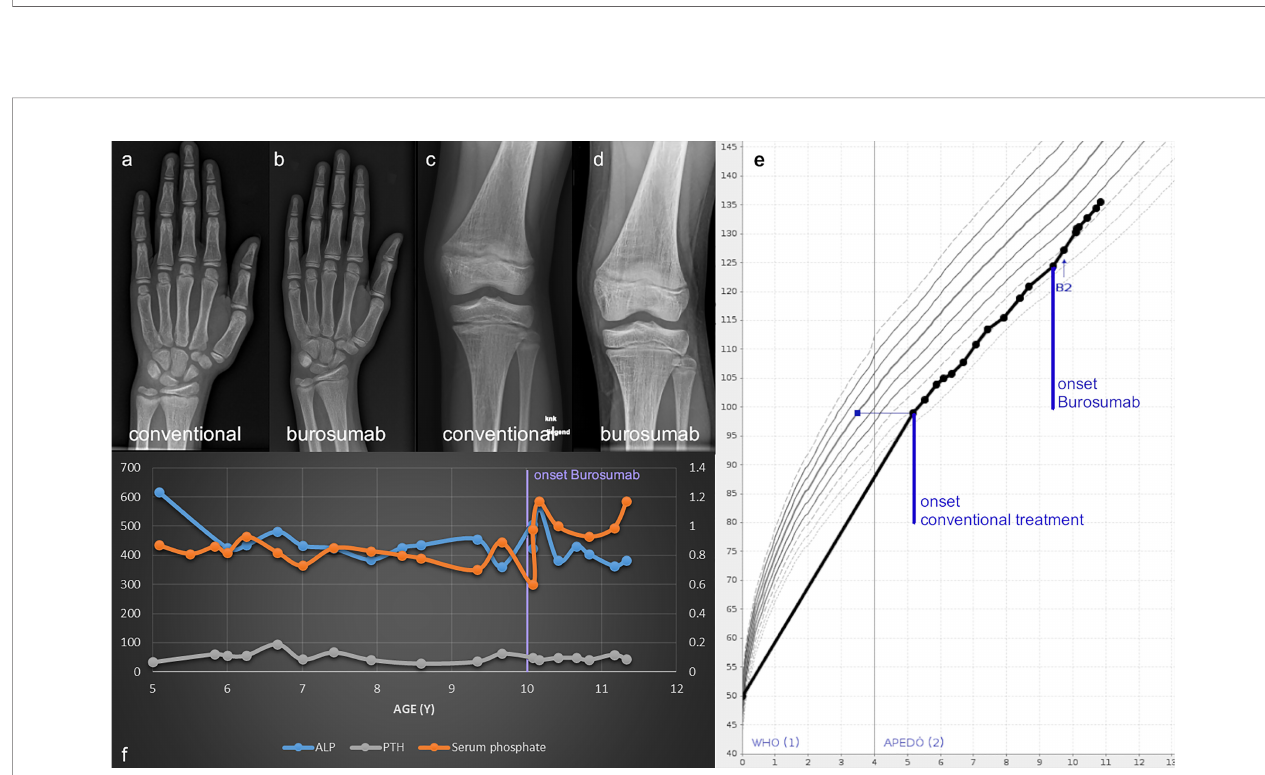
FIGURE 6 | Wrist and knee radiographs obtained before therapy onset (A, C) and at the one-year follow-up show resolution of rickets (B, D) in case 2. Linear growth, onset of treatment and thelarche (B2) are marked on the Austrian reference growth chart for girls (E) . The course of relevant biochemical parameters shows increase of serum Phosphate and normalization of ALP with onset of Burosumab treatment around 10 years of age (F)